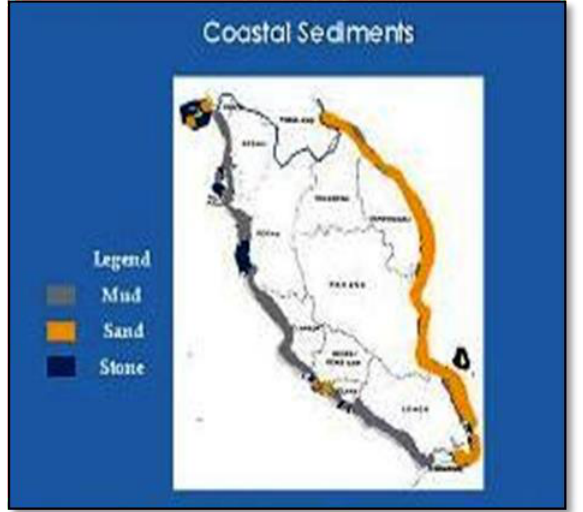
Figure 4. Bottom coverage by survey method (NOAA,